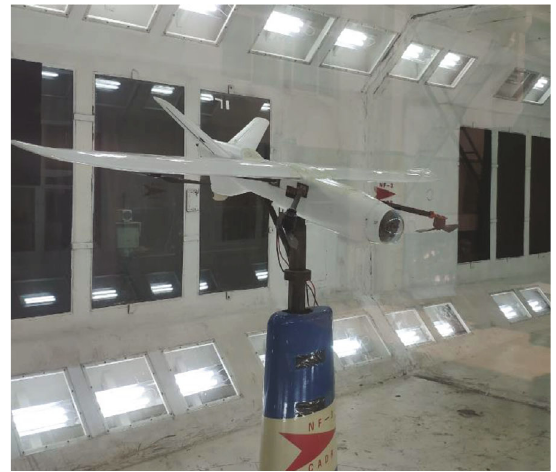
Figure 8: Wind tunnel test at high sideslip angle.